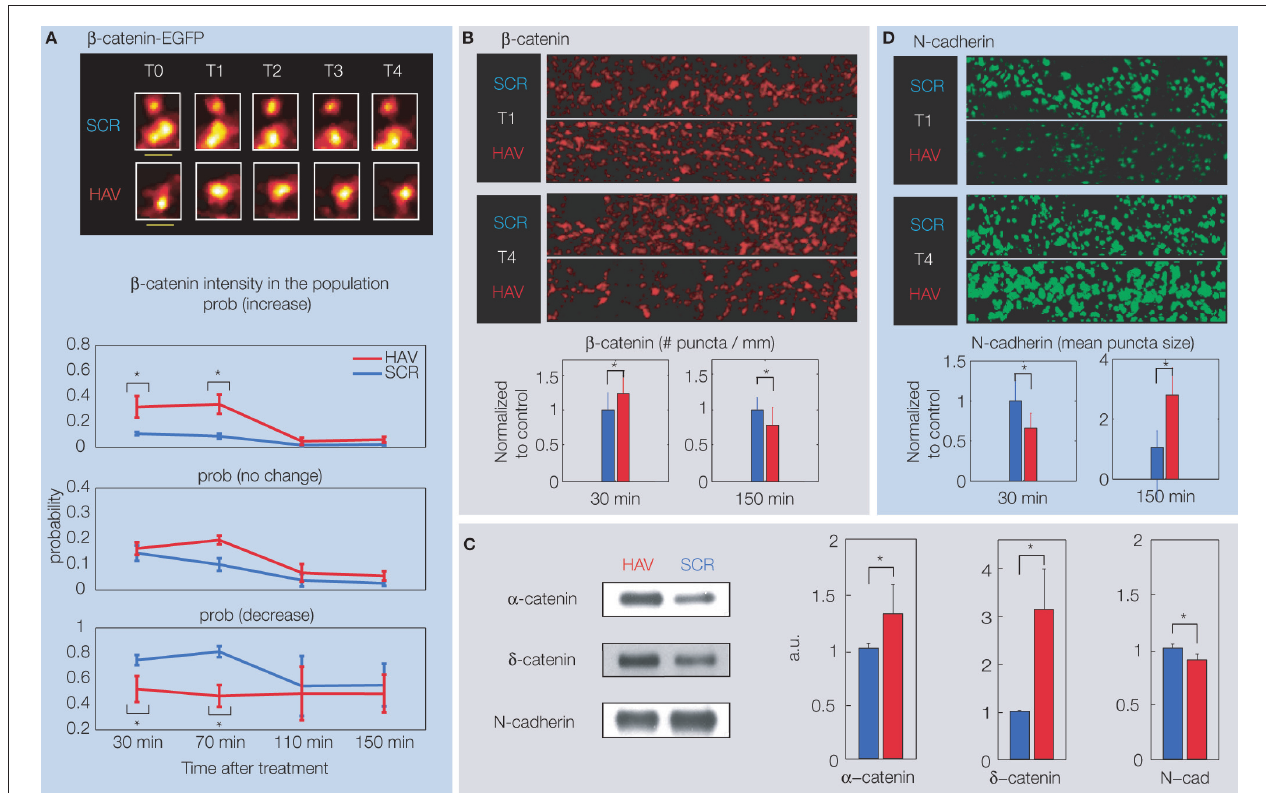
Figure 3 | (A) Top panel: Example spine images showing the intensity of over-expressed β -catenin-EGFP after HAV or control treatment (at T = 0 min). T0 (baseline) = − 10 min, T1 = 30 min, T2 = 70 min, T3 = 110 min, T4 = 150 min. The pseudocolor maps maximum intensity to white and minimum to black. Bottom panel: Summary data showing the probability at each timepoint of increase, decrease or no change in spine β -catenin with respect to the level at T0 = − 5 min. (B) Example images of dendrites stained for endogenous β -catenin at T1 and T2, and summary data, showing a treatment-induced increase at T1 and a decrease at T2 in # β -catenin puncta per micrometer. A